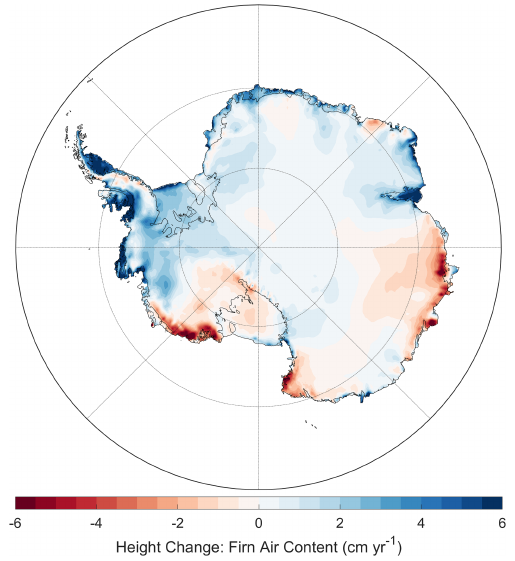
Figure 19. Rate of height change resulting from changes in firn air content over the Antarctic Ice Sheet between 31 March 2003 and 31 March 2021.